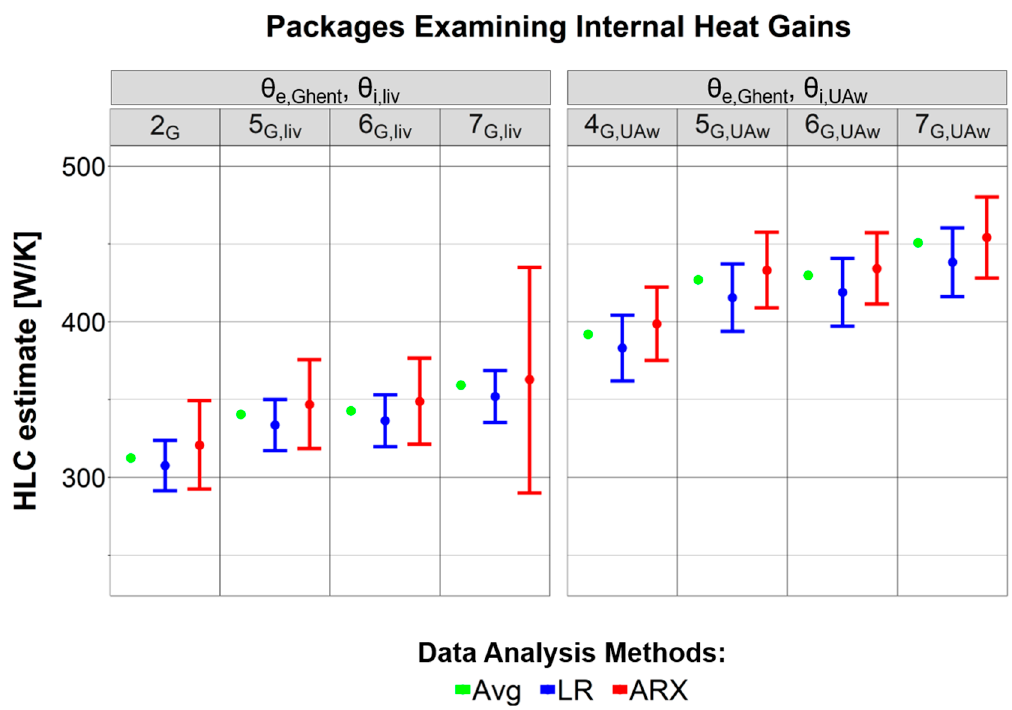
Figure 7. HLC estimates obtained by applying the Average method (Avg), Linear Regression (LR), and an ARX model on the data packages investigating the influence of the incorporation and representation of the internal heat gains. The dots indicate the mean estimates, and the whiskers represent the 95% confidence intervals.